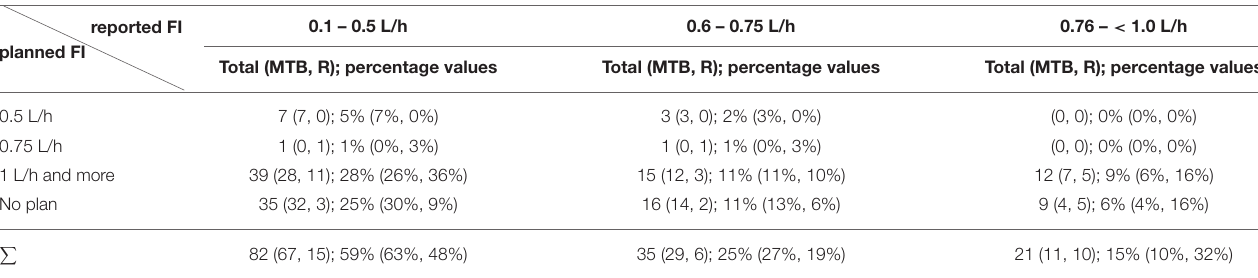
TABLE 5 | Post-race reported fluid intake in the post-race questionnaire and pre-race planned fluid intake in the pre-race questionnaire ( n = 138). reported planned FI